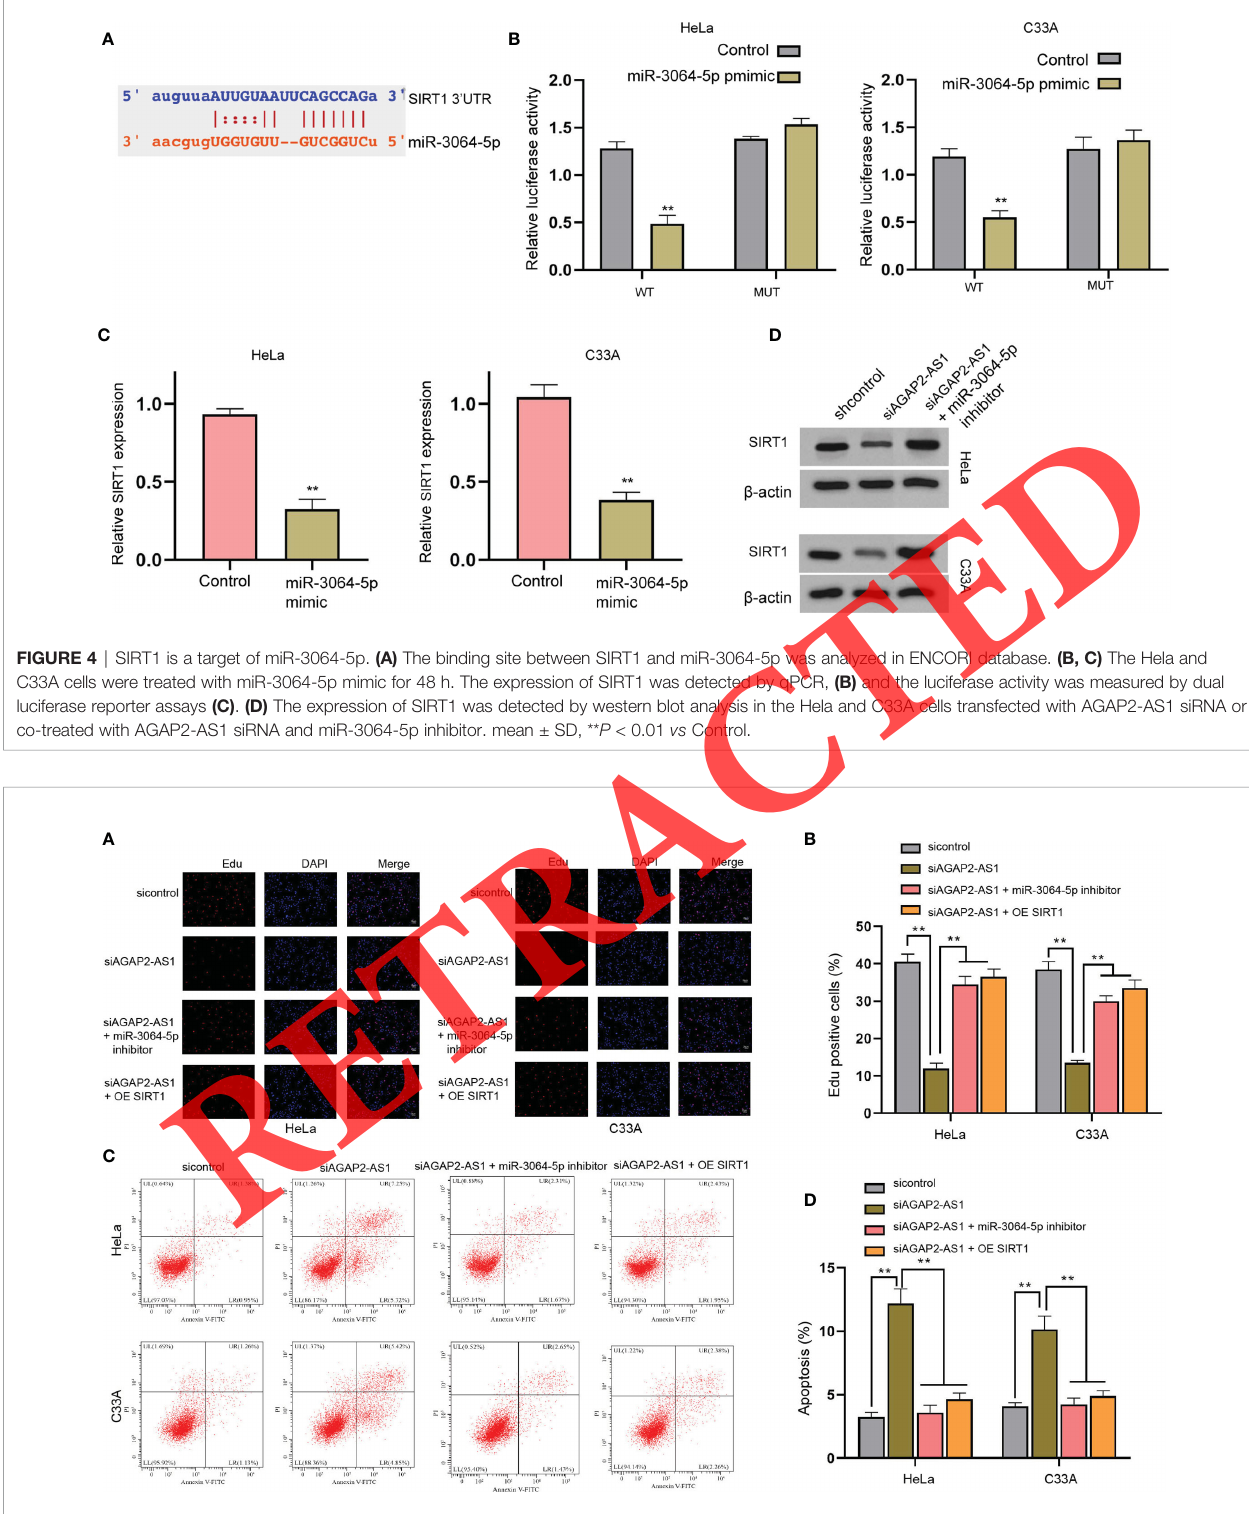
FIGURE 5 | MiR-3064-5p/SIRT1 axis is involved in EV AGAP2-AS1-induced cervical cancer cell proliferation in vitro . (A – D) The Hela and C33A cells were treated with EVs from Hela and C33A cells transfected with AGAP2-AS1 siRNA or co-treated with the EVs and miR-3064-5p inhibitor or SIRT1 overexpression vectors. (A, B) The cell proliferation was measured by Edu assays. (C, D) The cell apoptosis was evaluated by fl ow cytometry analysis. mean ± SD, ** P < 0.01.